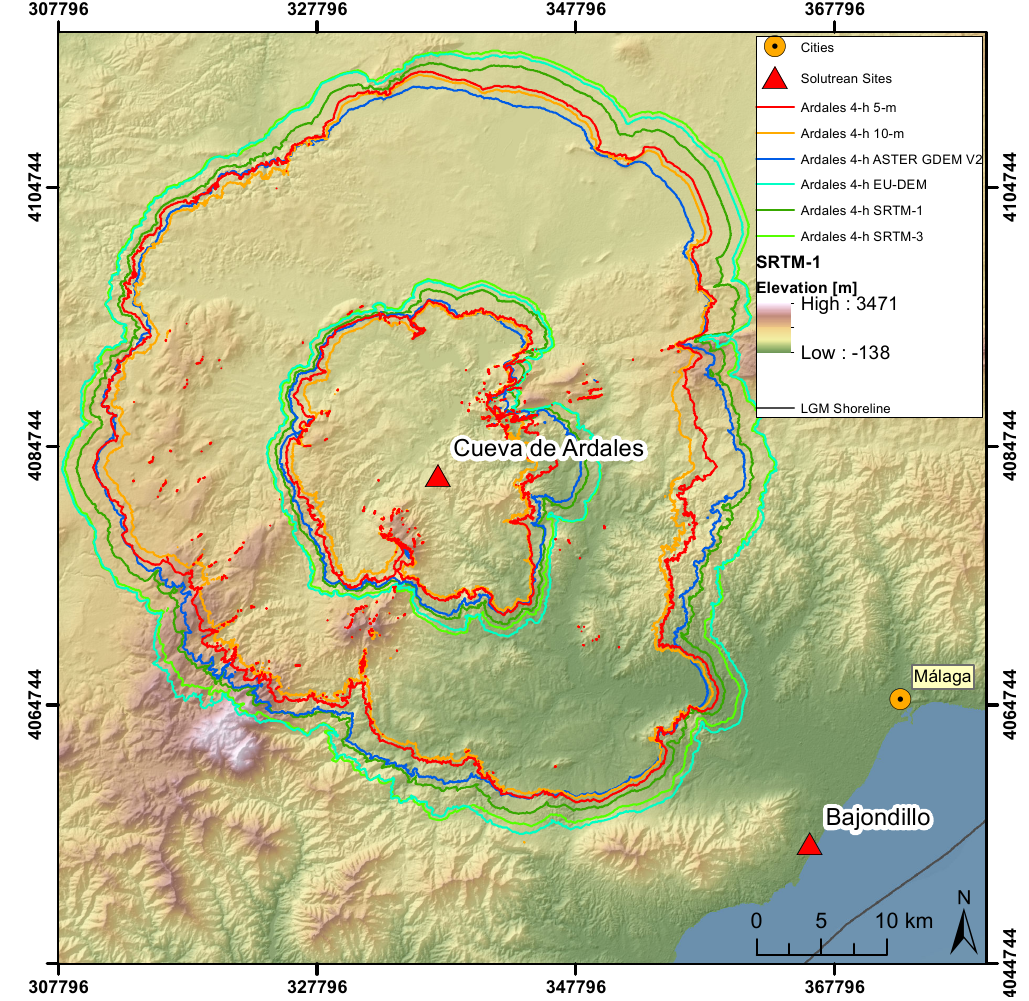
Figure 6. Comparison of the 4- and 8-h isochrones. Base map: SRTM-1